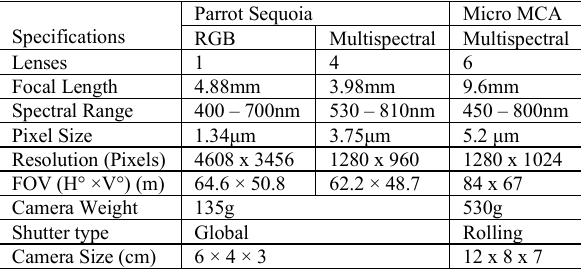
Table 2. Specifications of the Parrot Sequoia and Micro MCA